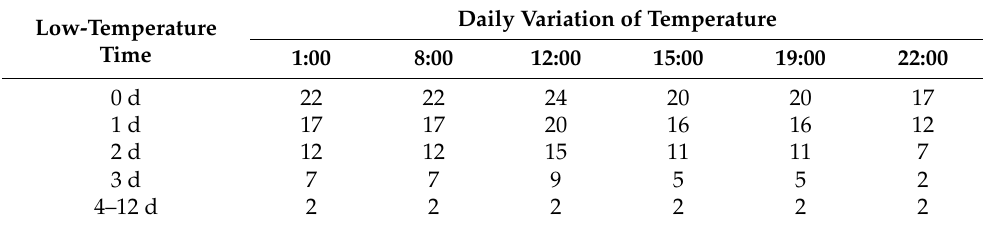
Table 2. The low-temperature program in the